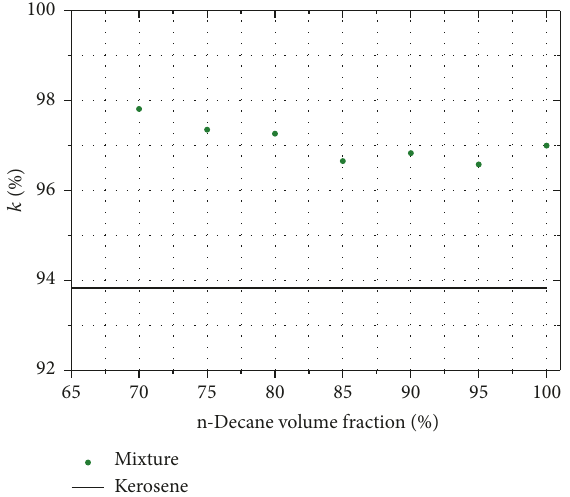
Figure 10: Comparison of combustion efficiency for the surrogate and the kerosene burning.